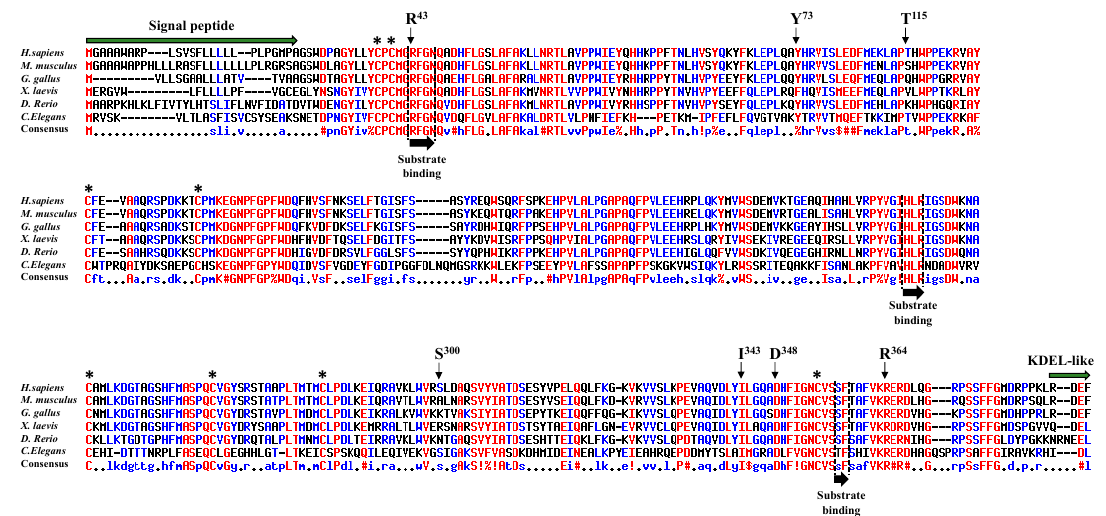
Figure 1. Alignment of POFUT1 protein sequences. Using the Multalin server, multiple sequence alignment for POFUT1 was done for different species such as Homo sapiens , Mus musculus , Gallus gallus , Xenopus laevis , Danio rerio, and Caenorhabditis elegans . Among the seven missense mutations found in POFUT1 from CRC patients, five of them corresponded to mutations of highly conserved residues (R 43 , Y 73 , I 343 , D 348 , and R 364 ), even located in a substrate-binding region for some residues such as R 43 . However, POFUT1 T 115 and S 300 , mutated in CRC patients, were not conserved among species. The three conserved regions known to be involved in binding to GDP-fucose are indicated with black arrows and specific sequences (signal peptide and KDEL-like ER-retention signal) with green arrows. Asterisks indicate the positions of conserved cysteines forming disulfide bridges.